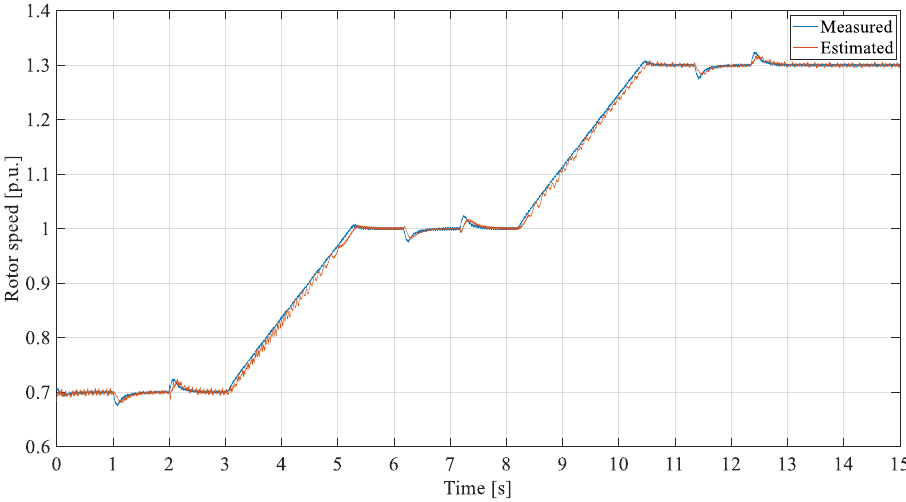
Figure 4. Behavior of the estimated and actual rotor speed in the whole test.